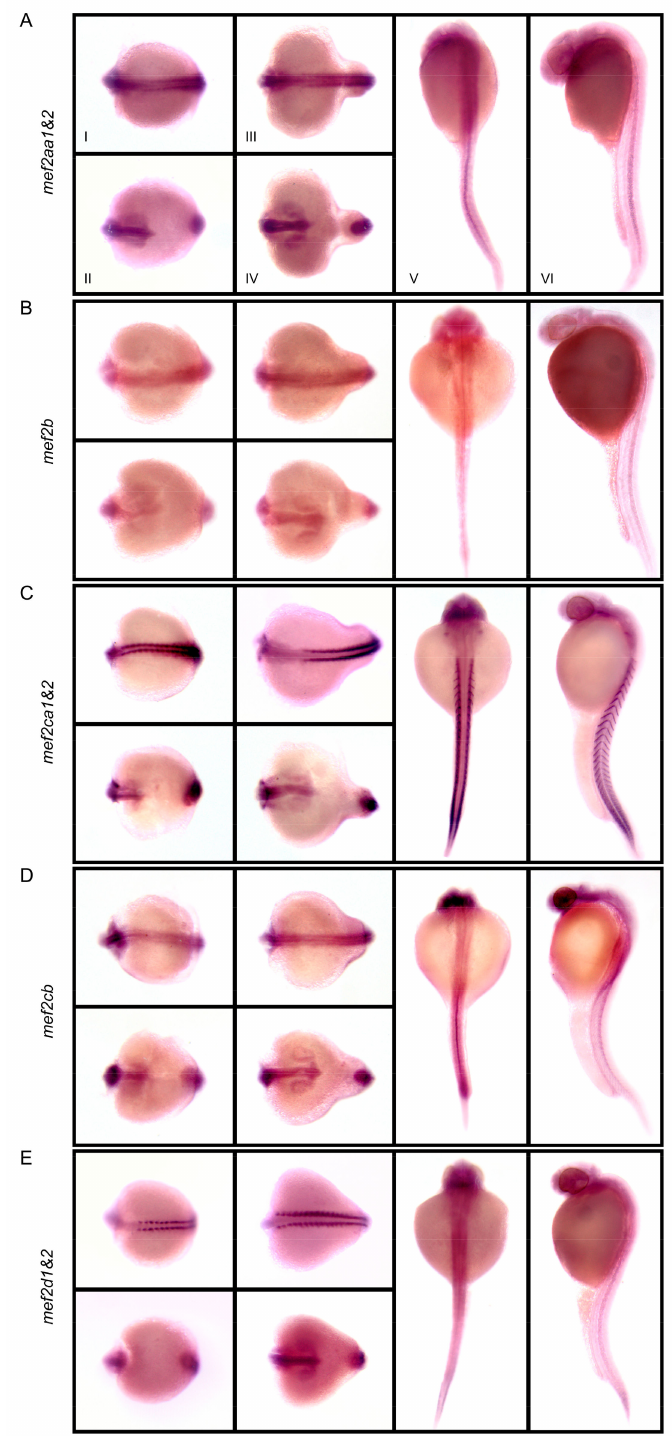
Figure 4. Embryonic expression patterns of Cyprinus carpio mef2 genes, including mef2aa1&2 ( A ), mef2b ( B ), mef2ca1&2 ( C ), mef2cb ( D ), and mef2d1&2 ( E ). Whole-mount in situ hybridization was conducted on C. carpio embryos at 8-somite stage (I, II), 18-somite stage (III, IV) and 24 hpf (V, VI). The two ohnologous versions were detected together, thus being denoted as " 1&2 ". I and III: Dorsal view, anterior to the left; II and IV: Ventral view, anterior to the left; V: Dorsal view, anterior up; VI: Lateral view, anterior